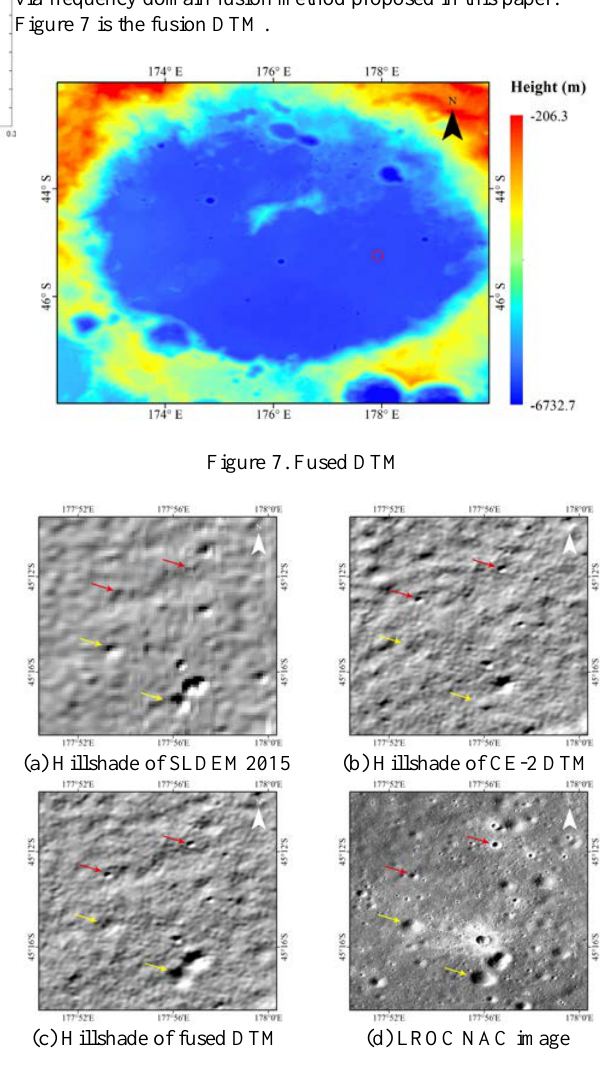
Figure 8. Comparisons of the DTMs in local area. The red arrows indicate the details only in CE-2 DTM. The yellow arrows indicate the details only in the SLEDM2015 Using the shade map to evaluate our method, we found the new fusion DTM contains more information than both the CE-2 DTM and SLDEM2015.